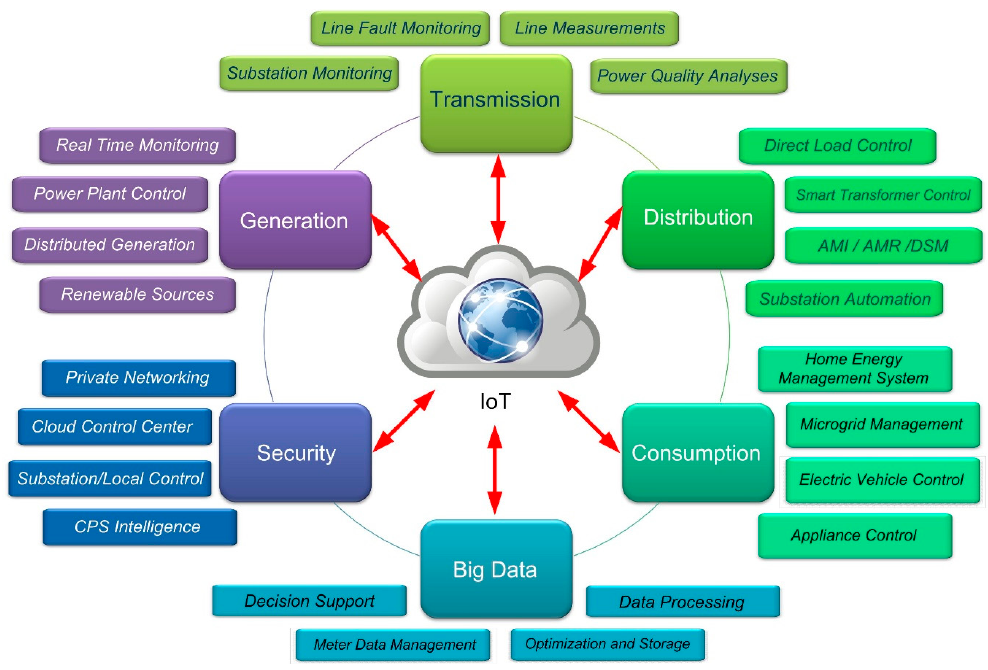
Figure 4. Open research topics in the context of IoT-based SG and applications [77].